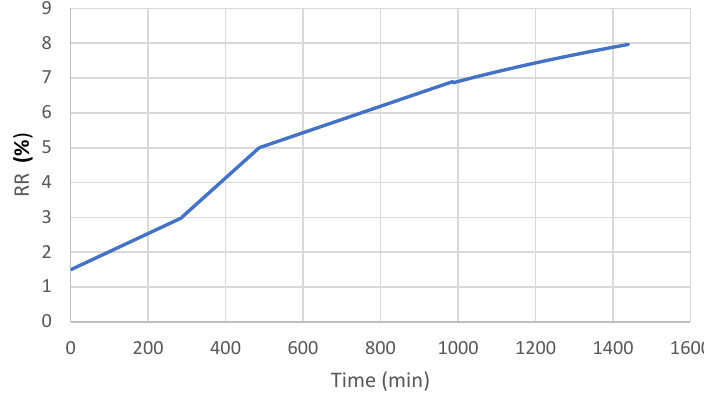
Figure 5. View of the road inside an open pit mine. A fleet of 10 trucks is used, where each truck has a weight of 150 Ton, and a transport capacity of 150 ton, so that the total gross weight of a loaded truck is 300 ton. With these characteristics, the temporal wear model expressed in rolling resistance for 24 h (1440 min), is shown in Figure 6, and this function is the one used in this simulation. is shown in Figure 6, and this function is the one used in this simulation.